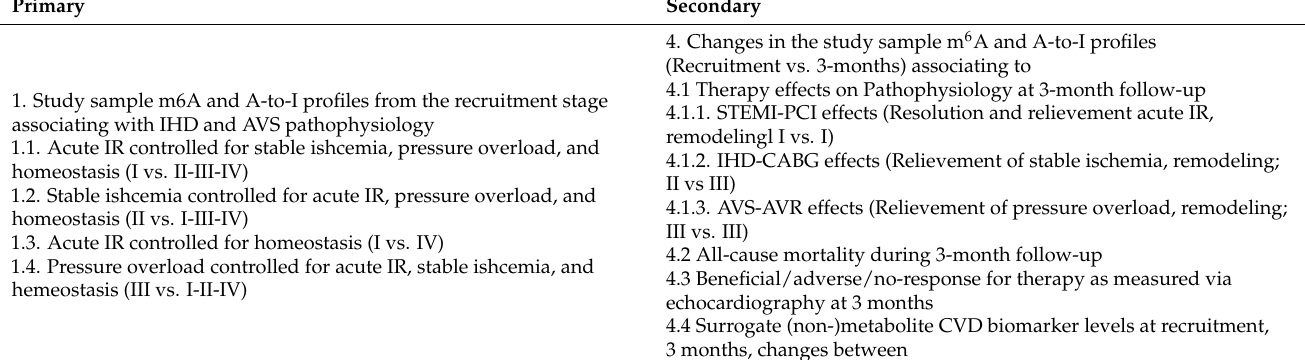
Table 3. Planned outcomes of the IHD-EPITRAN study. Outcome 1 and outcomes 2–5 encase inter- and intra-cohort comparisons, respectively. Morbidity parameters: Section 2.3.2. A-to-I , adenosine-to-inosine; AVR , aortic valve replacement (III); AVS , aortic valve stenosis; CABG , coronary artery bypass grafting (II); CCTA , coronary computed tomography angiogram (IV); m 6 A , N 6 -methyladenosine; IR , ischemia-reperfusion; PCI , percutaneous coronary intervention; STEMI , ST-elevation MI